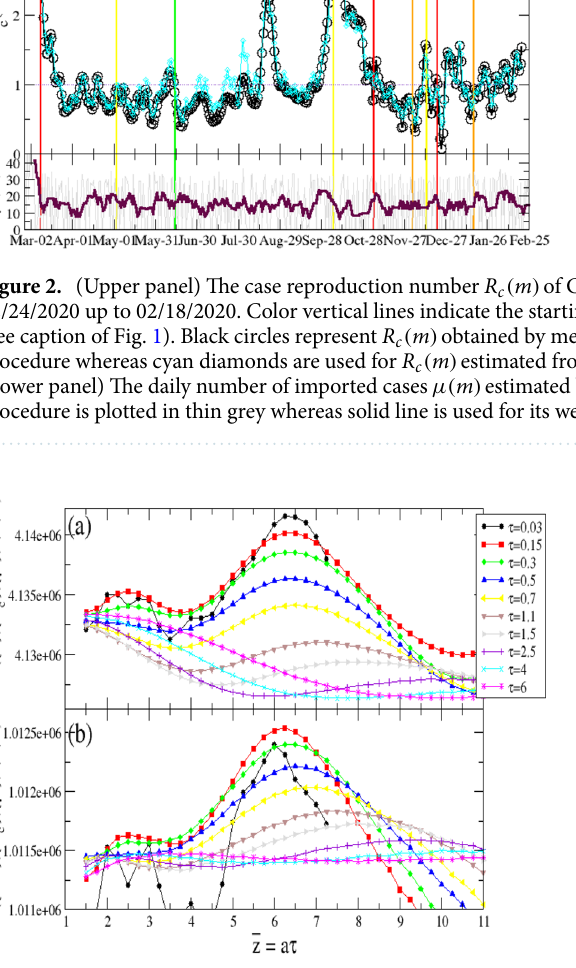
, , , z , σ , V ) obtained from the daily incidence of COVID-19 in I R c µ { } { } { } a τ . Different curves correspond to different values of τ , which implies = , , , z , σ , V I (φ) R c µ with I (φ) ( m ) given in Eq. (4) for { } { } { } (cid:30) (cid:31)